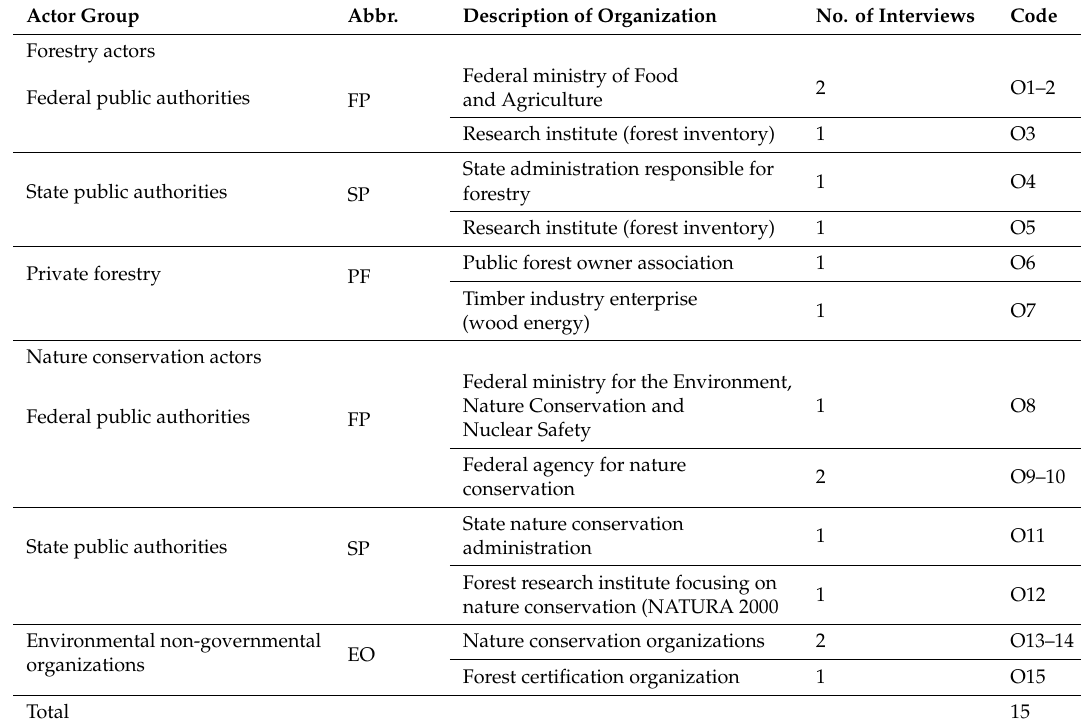
Table 1. Major actor groups and relevant organizations (forestry, nature conservation) interviewed for this